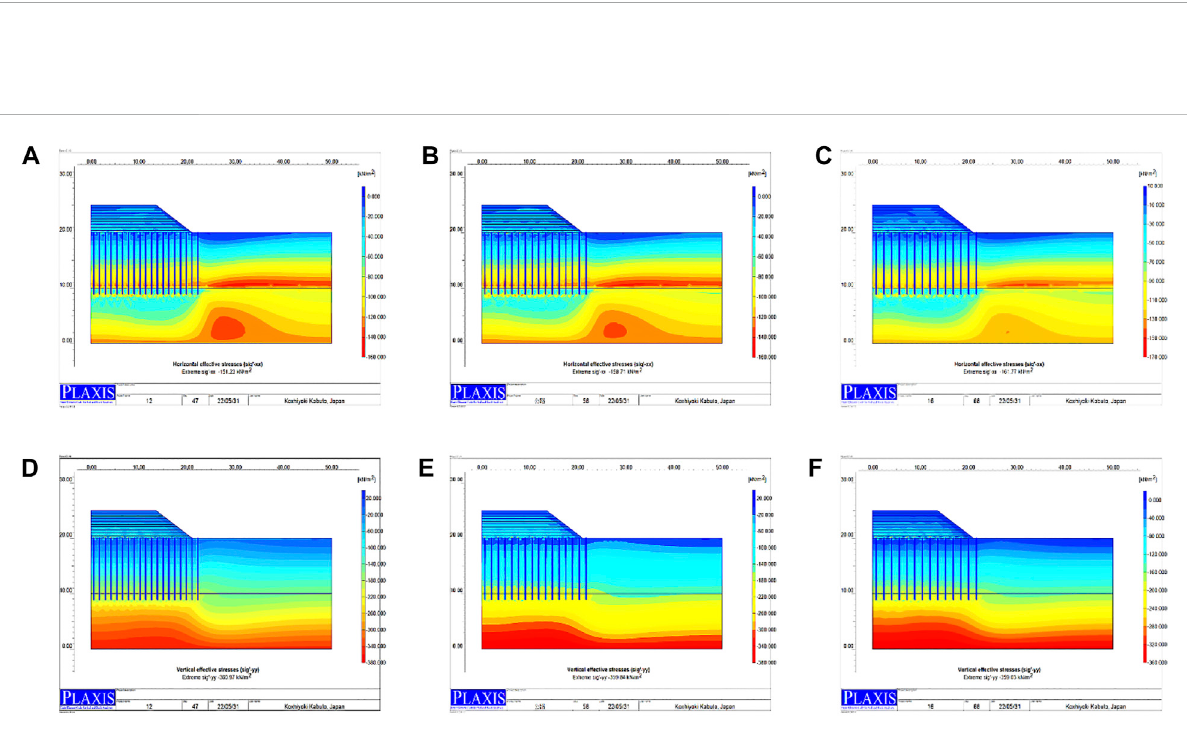
The statistical diagrams of the horizontal and vertical soil pressures of the roadbed under different cushions are shown in the fi gures below: The numerical method was used to analyze the pile length, pile distance, and the thickness of the gravel cushion of the CFG pile composite foundation. The changes in the pile length had a